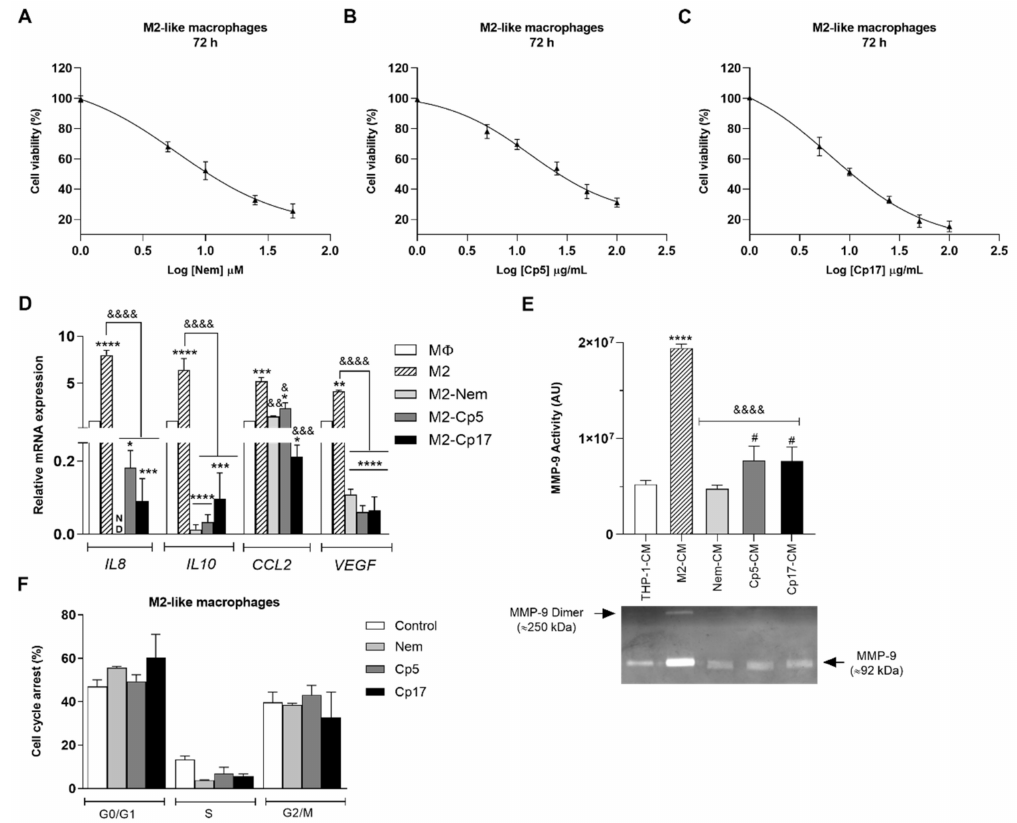
Figure 2. E ff ect of Nem, Cp5 and Cp17 on M2-like macrophages. ( A – C ) MTT assay: M2-like macrophages were exposed to increasing concentrations of Nem ( A ), Cp5 ( B ) and Cp17 ( C ) for 24, 48 and 72 h; ( D ) mRNA levels of IL8, IL10, CCL2 and VEGF after 24 h of exposure to 21 µ M, 44 µ g / mL, 16 µ g / mL of Nem, Cp5 and, Cp17, respectively (IC 50 / 72 h); ( E ) MMP-9 activity was evaluated by zymography in di ff erent supernatants (THP-1-CM, M2-CM, Nem-CM, Cp5-CM and Cp17-CM); ( F ) Cell cycle analysis after 24 h of exposure to 21 µ M, 44 µ g / mL, 16 µ g / mL of Nem, Cp5 and, Cp17, respectively (IC 50 / 72 h). Data are reported as the mean ± SD of three independent experiments. * p < 0.05, ** p < 0.001, *** p < 0.0001, **** p < 0.0001 vs. M Φ or THP-1-CM, & p < 0.05, && p < 0.01, &&& p < 0.001, &&&& p < 0.0001 vs. M2-like macrophages or M2-CM, # p < 0.05 vs. Nem-CM. N.D. Not detected. A.U. arbitrary units.